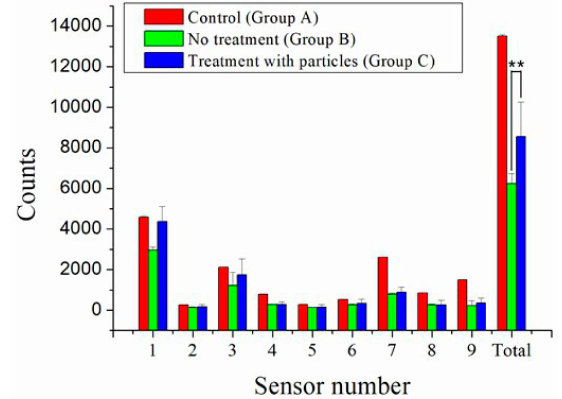
Figure 7. Rat locomotor activity recorded in the activity cages. Group A (red columns) was the control untreated group. Group B (green columns) was subjected to the experimental bone fracture procedure without any other treatment. Group C (blue columns) was subjected to the experimental bone fracture procedure followed by the administration of analgesics-loaded microparticles to the bone fracture site. The asterisks denote a significant di ff erence ( p < 0.01) between groups B and